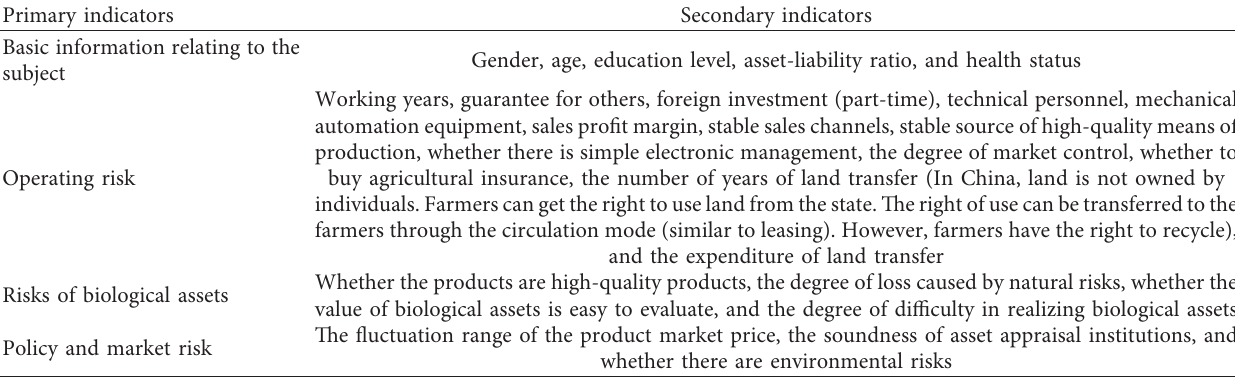
Table 1: Preliminary selection of the risk assessment index system of biological asset mortgage